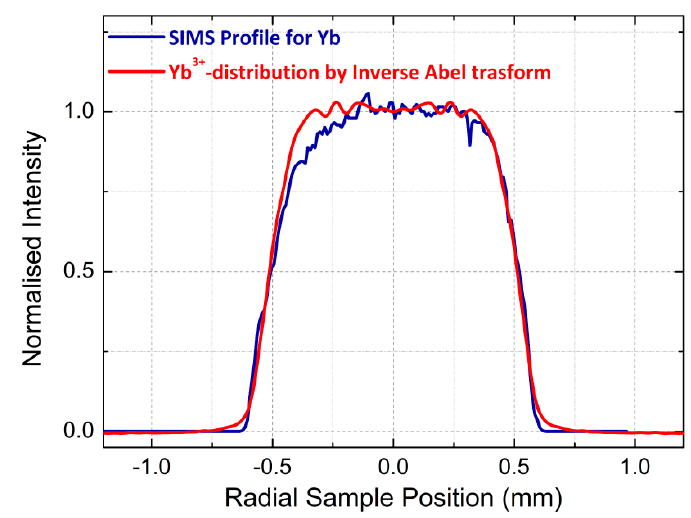
Figure 8. Comparison between the active-dopant profile obtained with the current method (red curve) and the profile measured by a SIMS analysis (blue